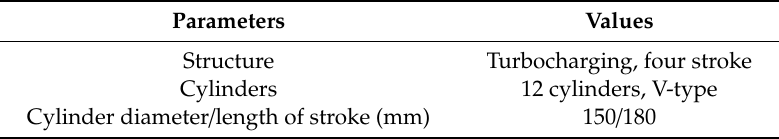
Table 1. Structural parameters and performance indexes of diesel